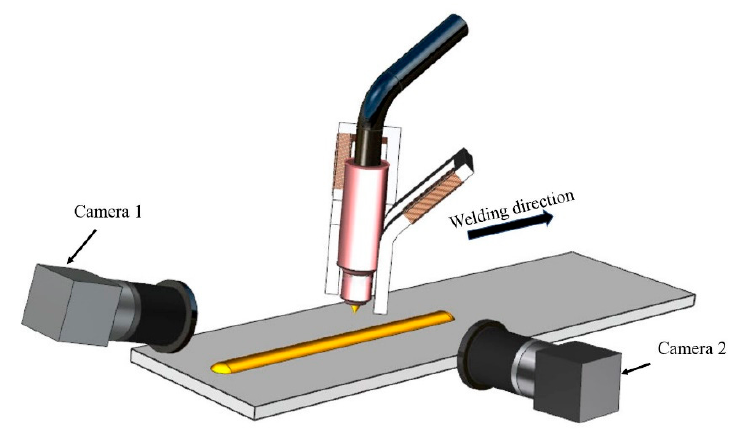
Figure 19. The schematic diagram of experimental platform.